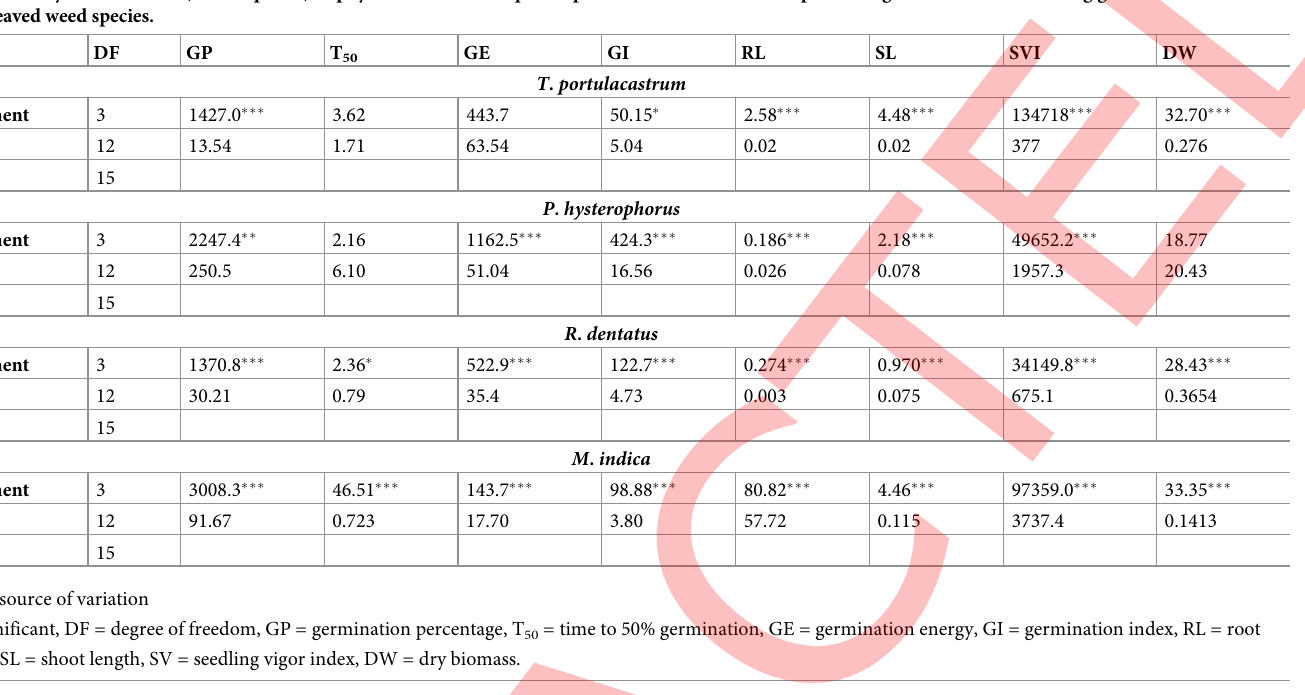
and M . indica reduced seed germination of P . hysterophorus by 6.25 and 0.00%. However, C . occidentalis extract reduced seed germination of R . dentatus by 26.2%.